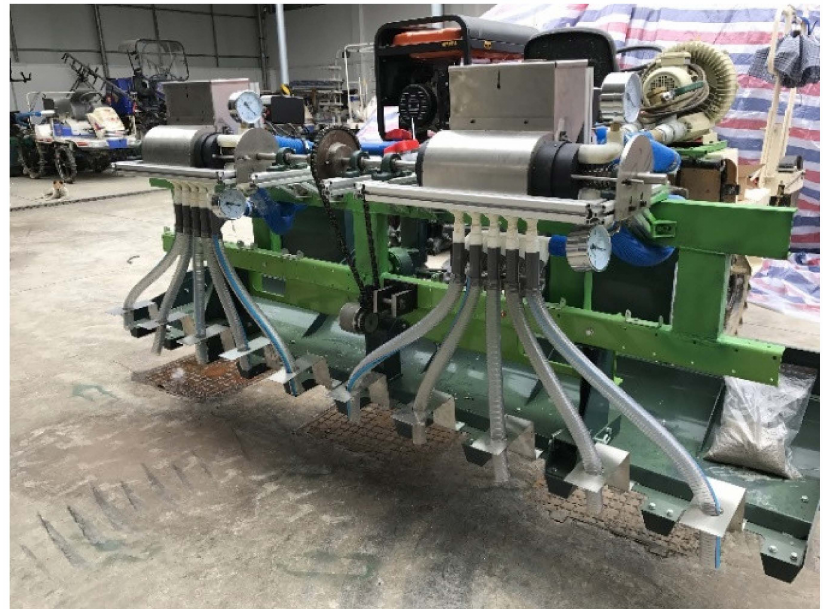
Figure 2. The practicality picture of hill-drop pneumatic central cylinder direct-seeding machine for hybrid